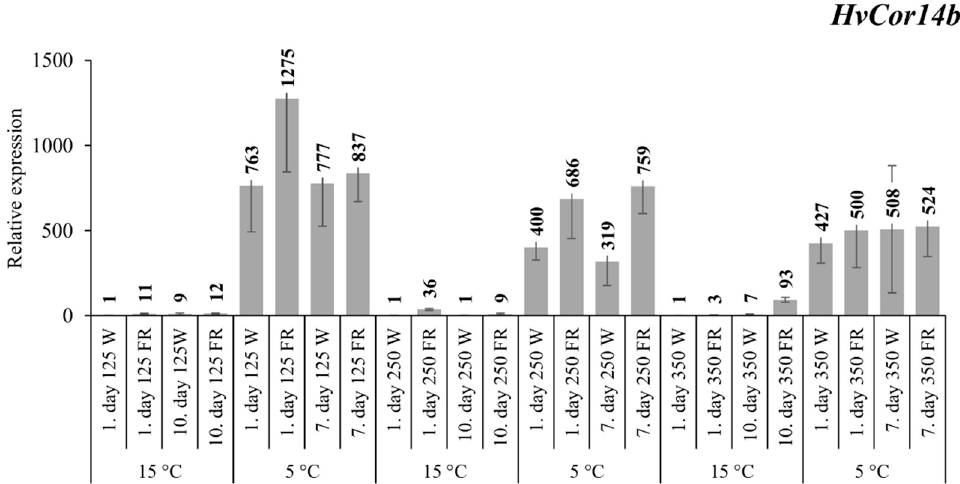
Figure 2. The expression pattern of the HvCOR14 b gene with white light and low R:FR illumination. Conditions are the same as in Figure 1.